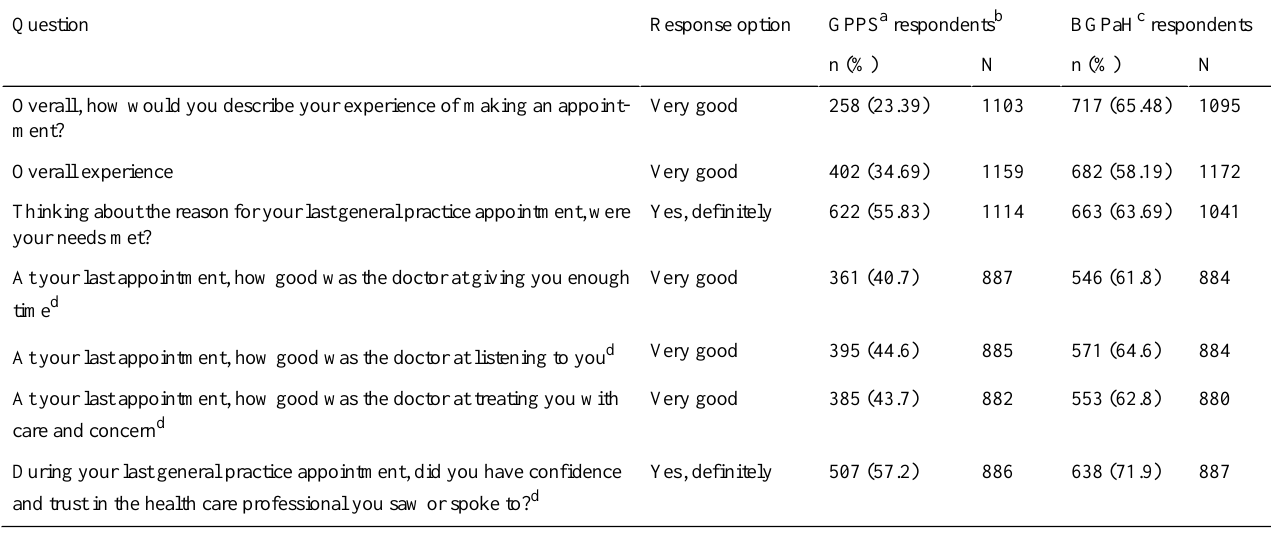
Table 1. Patients’ experience of Babylon GP at Hand compared with matched respondents from the national GP Patient Survey (summary data). GP: general